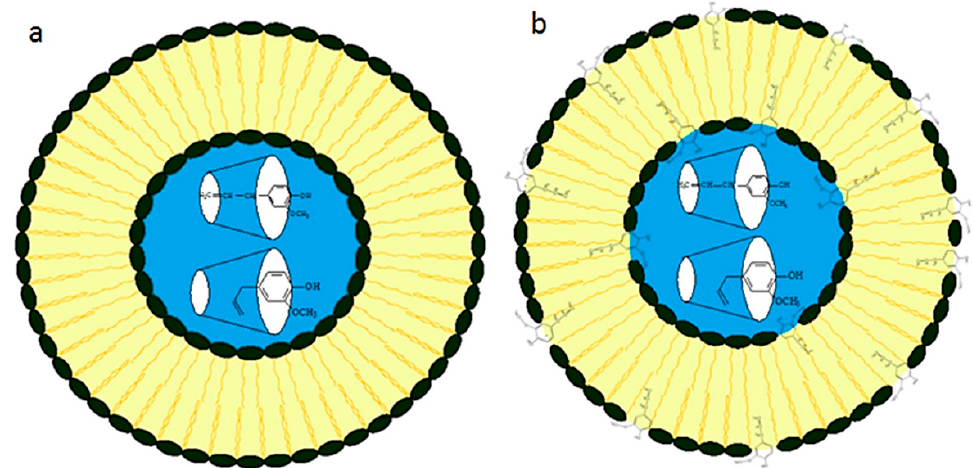
Figure 2. Suggested localization of eugenol (Eug) in Eug-loaded DCL ( a ) and DCL2 ( b ). The figure is reused with permission from Elsevier [44].